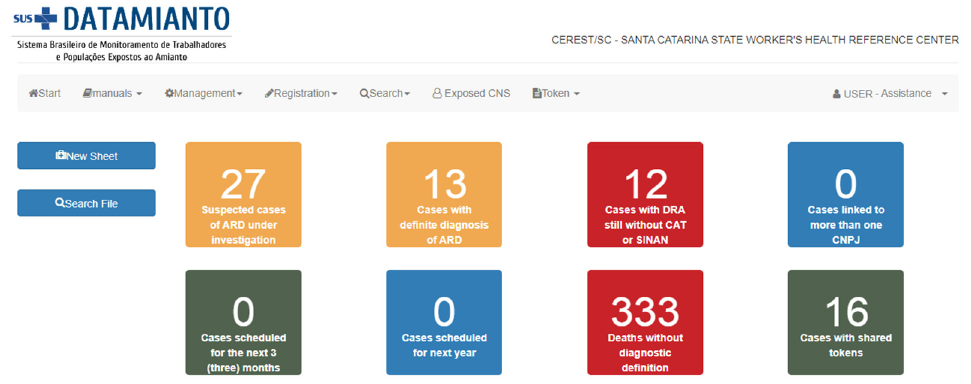
Figure 1. Access to the assistance module, and its alerts in the Datamianto system. Source: Datamianto system, Santa Catarina State Cerest, Brazil, 2022.